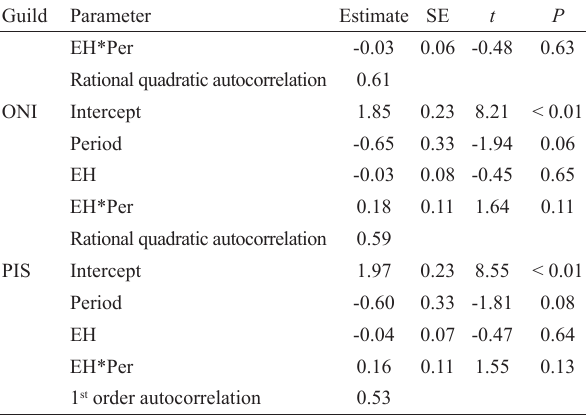
Tab. 1. Parameter estimates of generalized least squares linear models relating the beta diversity of each guild